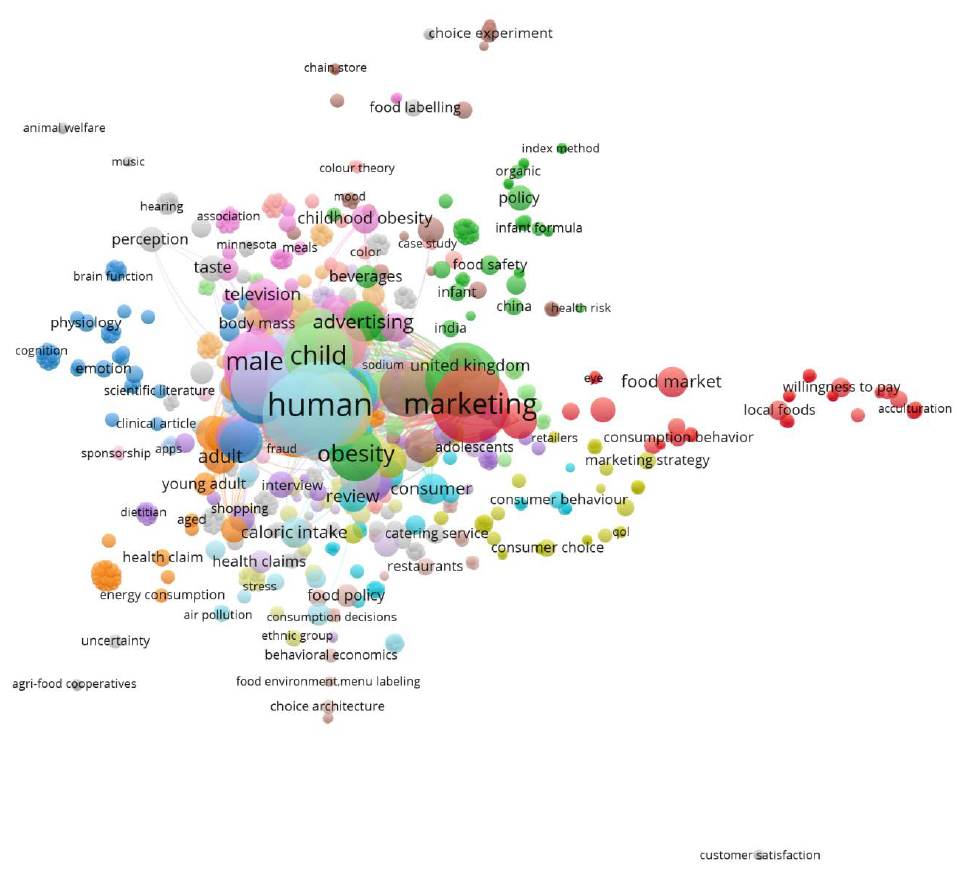
Figure 5. Co-occurrences of all keywords (one as a minimum number of occurrences of a keyword).